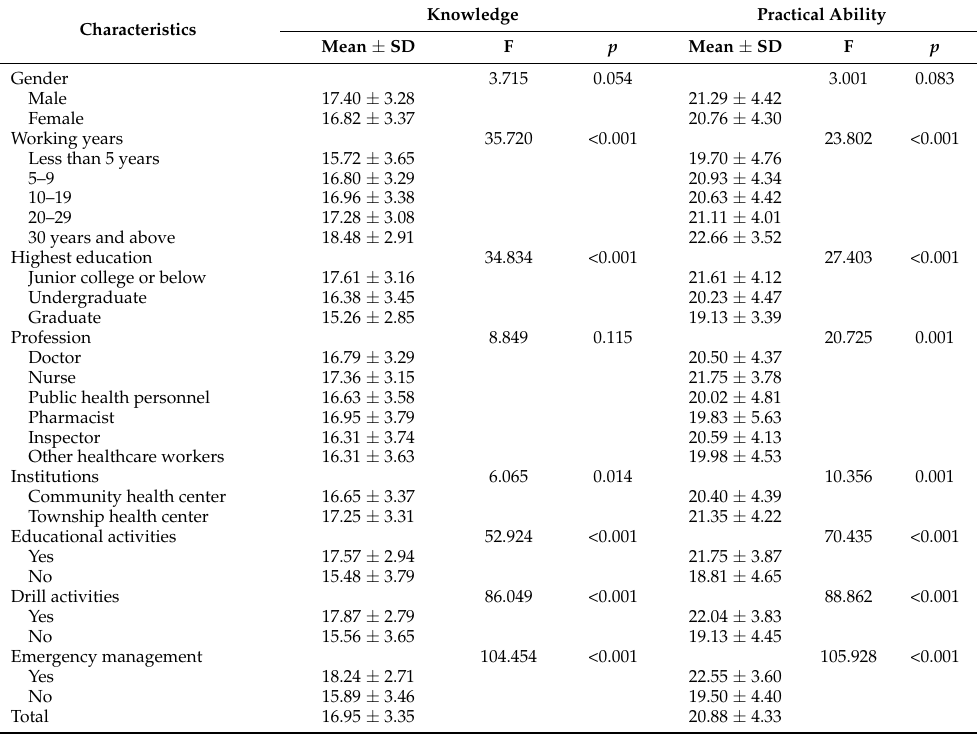
Table 4. Response capacities for PHEs of healthcare workers and associated factors (Kruskal– Wallis